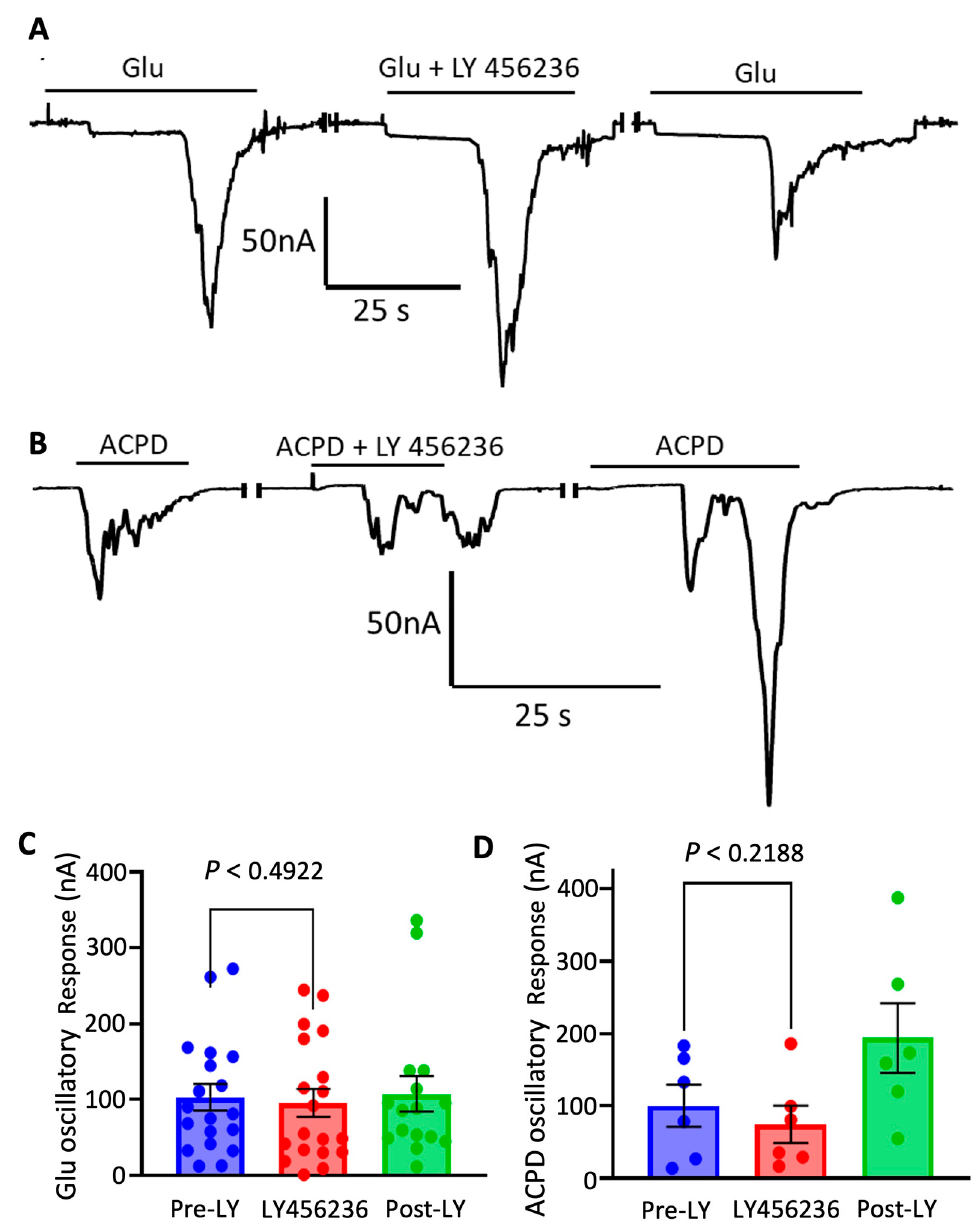
Figure 4. Antagonism of mGluR1 has no effect on metabotropic oscillations. ( A ) Glutamate currents of a microtransplanted oocyte in response to application of the mGluR1 antagonist, LY 456236, with each application separated by 4 min of wash by Ringer’s solution. No significant effect on metabotropic responses was shown ( C ) when LY 456236 was co-applied with glutamate ( n = 13 oocytes from 4 frogs). ( B ) ACPD currents of a single microtransplanted oocyte in response to application of the mGluR1 antagonist, LY 456236, with each application separated by 4 min of wash by Ringer’s solution. There was no significant change in amplitudes ( D ), although a slight increase in current was observed in some oocytes after a wash period ( n = 6 oocytes from 2 frogs).